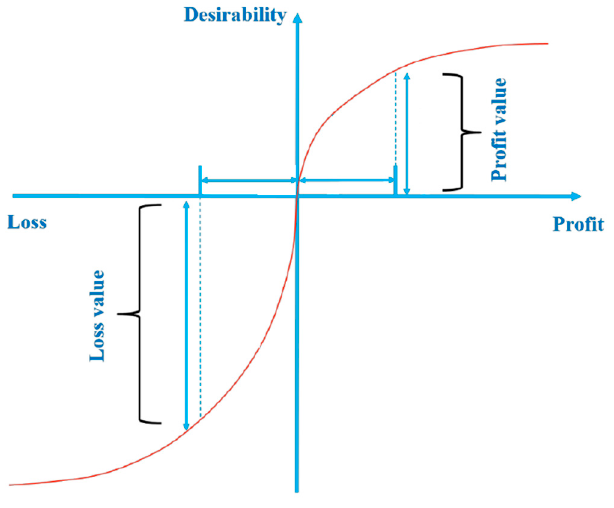
Figure 1. Outline of the desirability function [96].